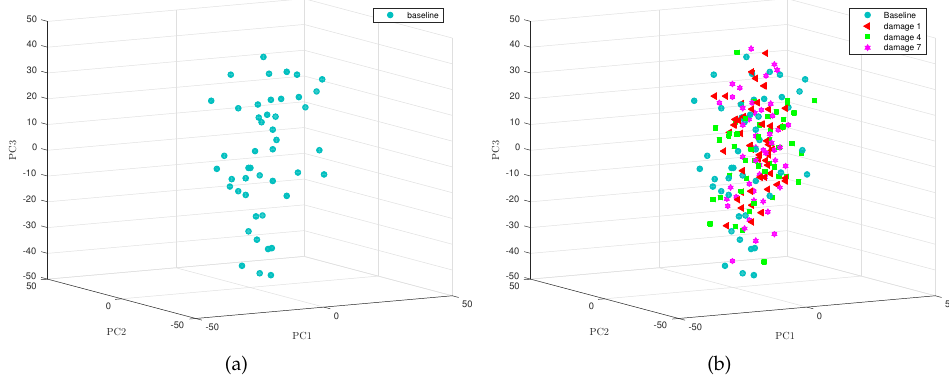
Figure 3. ( a ) Baseline sample and ( b ) sample from the wind turbine to be